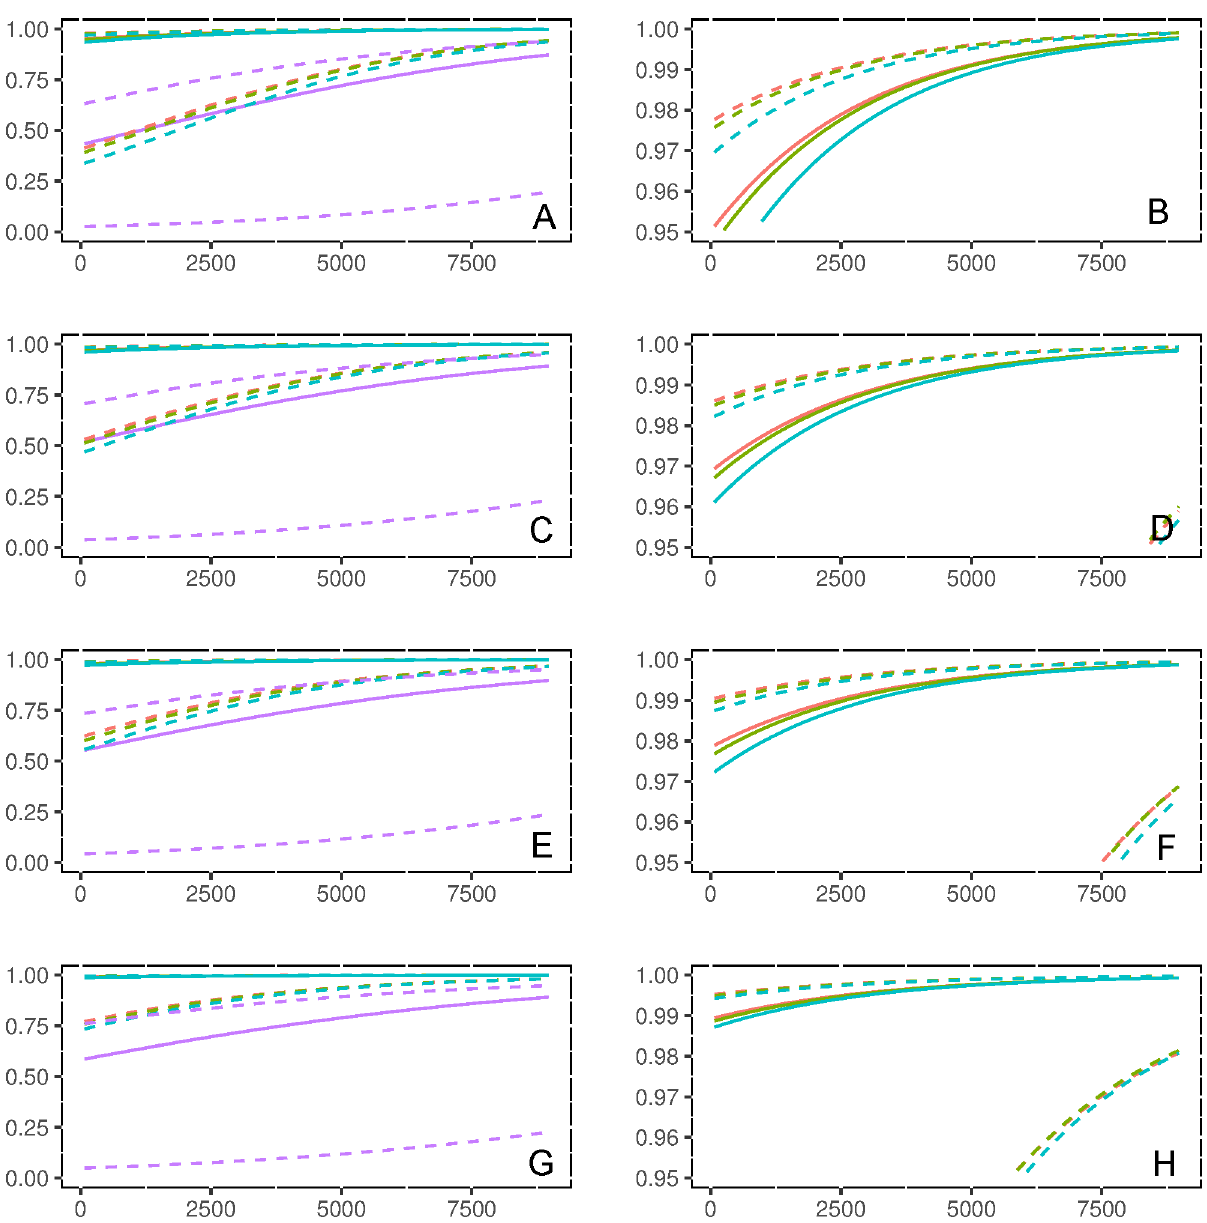
Fig 2. Predicted recoveryrate (rr) using the mixed logistic model as a function of gene length (rr), read length and divergence between target and referencetranscriptomes: red lines denote 0% divergence; green 5%; blue 15% & purple 30%. Solid lines correspond to the medianof predictions,conditionedon randomvariationamonggenes, with 80% prediction intervals indicatedby dashed lines. Read length increasesdownward, and panels to the right represent a magnifiedview of the upper 5th quantileof rr scores to better visualizedifferences betweenlow divergent sequences:100 base reads (A & B); 150 bases (C & D); 200 bases (E & F); 350 bases (G & H).